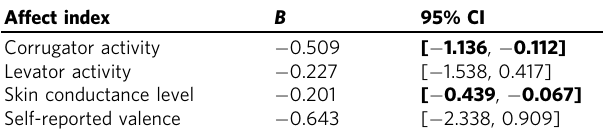
Table 7 Indirect effects of conservatism on inequality treatment effects as mediated by economic system justi fi cation (ESJ) in the integrated physiological dataset.